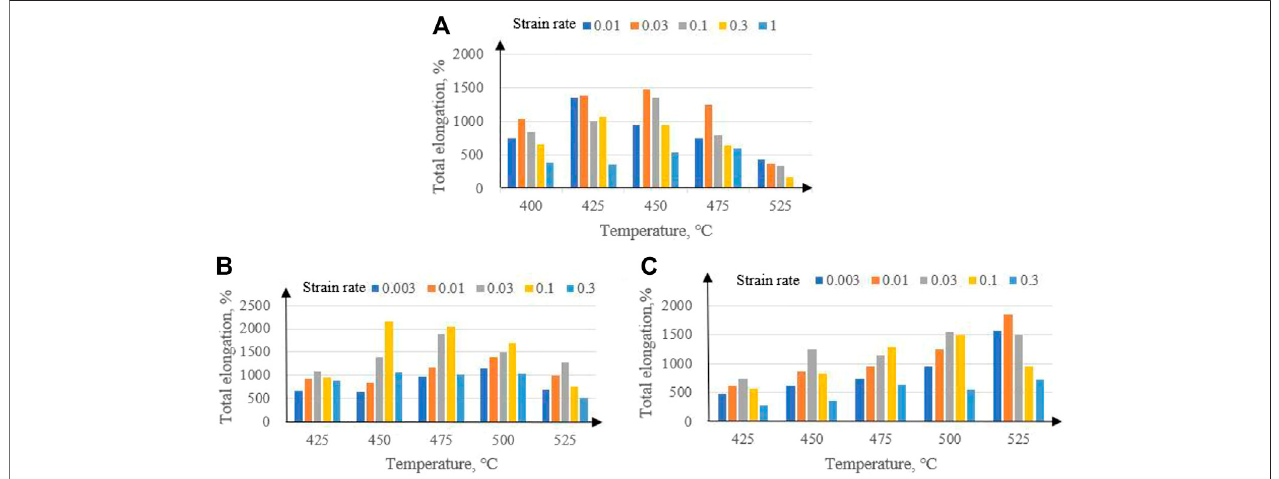
FIGURE 2 | Changes in total elongation with strain rate at different deformation temperatures in the Al-Mg-Sc alloy with grain sizes of 1.6 μ m (A) , 2.6 μ m (B) and 2.9 μ m (C) (Liu and Ma, 2011).